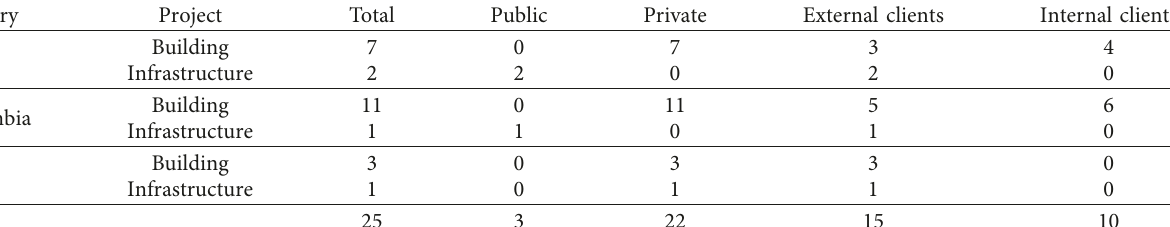
Table 6: Summary of project characteristics.